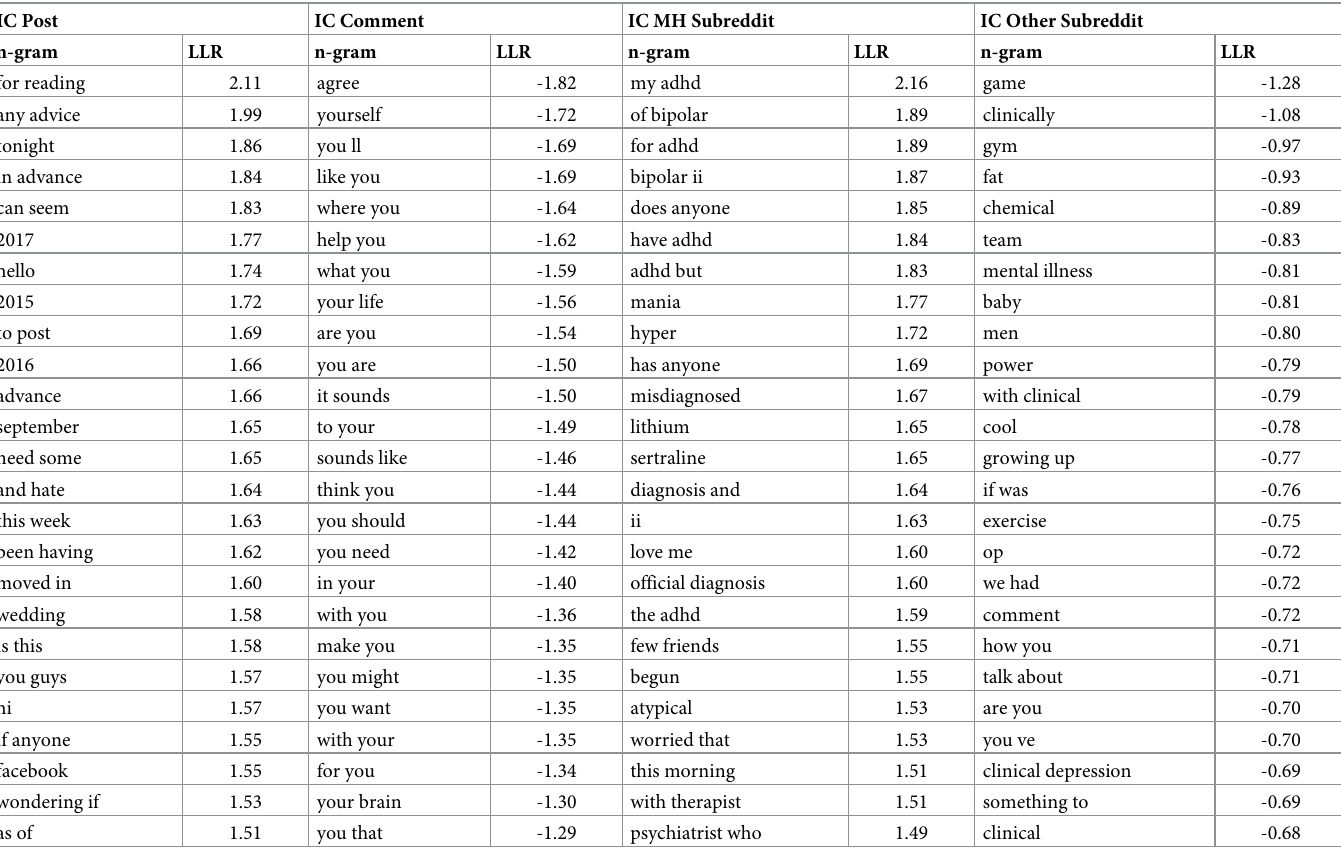
Table 2. Results of our N-Gram (LLR)